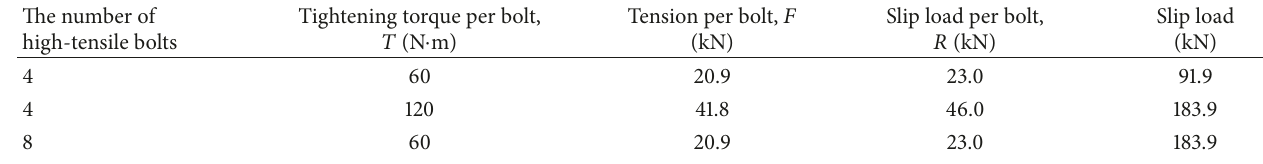
Table 1: Slip load according to the number of bolts and tightening torque.